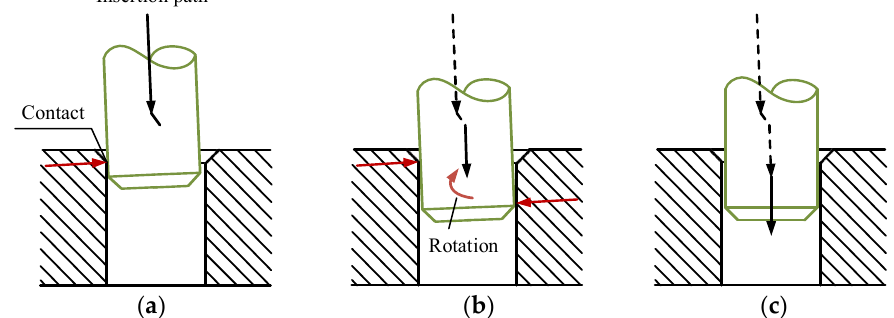
Figure 13. The trajectory planning strategy during the insertion process. ( a ) Insertion with an angle error; ( b ) Compensation for the angle error; ( c ) Insertion after angle compensation.